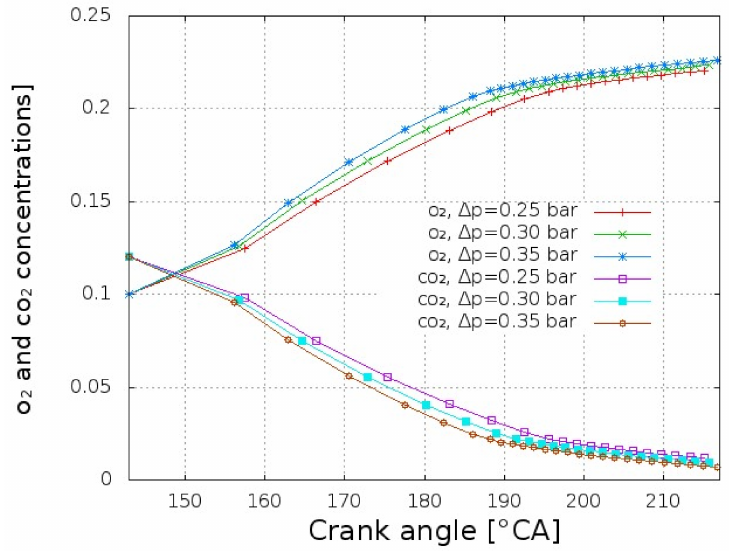
Figure 11. The variation of the concentration of O 2 and CO 2 over time for different pressure